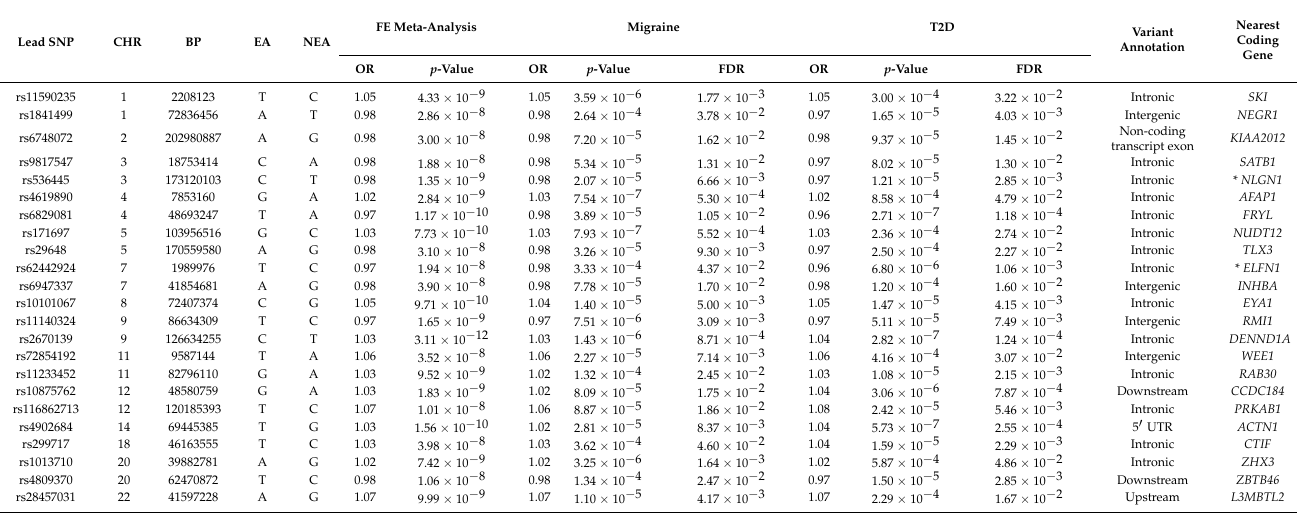
Table 3. Novel LD-independent ( r 2 < 0.1) lead SNPs from cross-trait meta-analysis of migraine and T2D GWAS ( P meta < 5 × 10 − 8 ; single-trait FDR-adjusted p < 0.05).